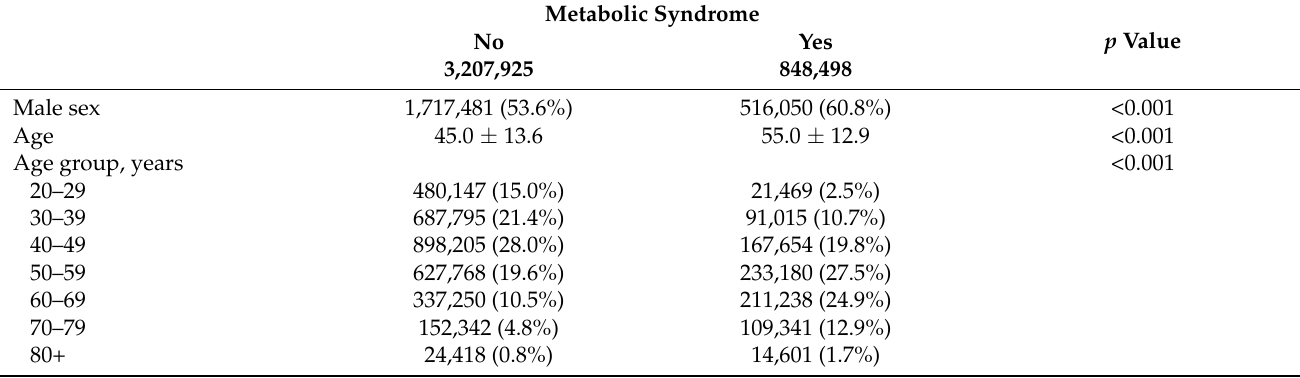
Table 2. Baseline characteristics of patients with versus without metabolic